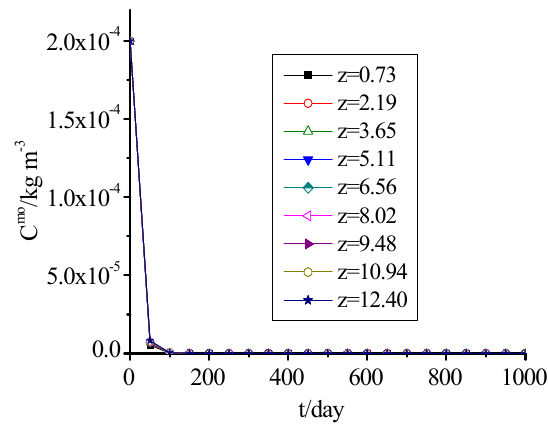
Figure 12. DO concentration change with